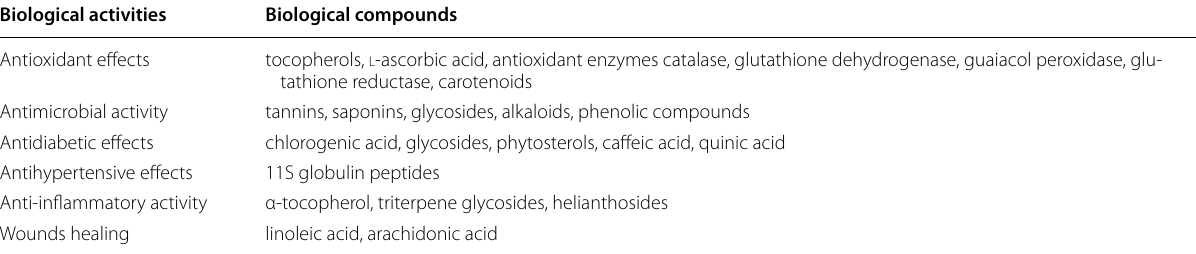
Table 3 Biological activities and compounds of sunflower seed and sprout Biological